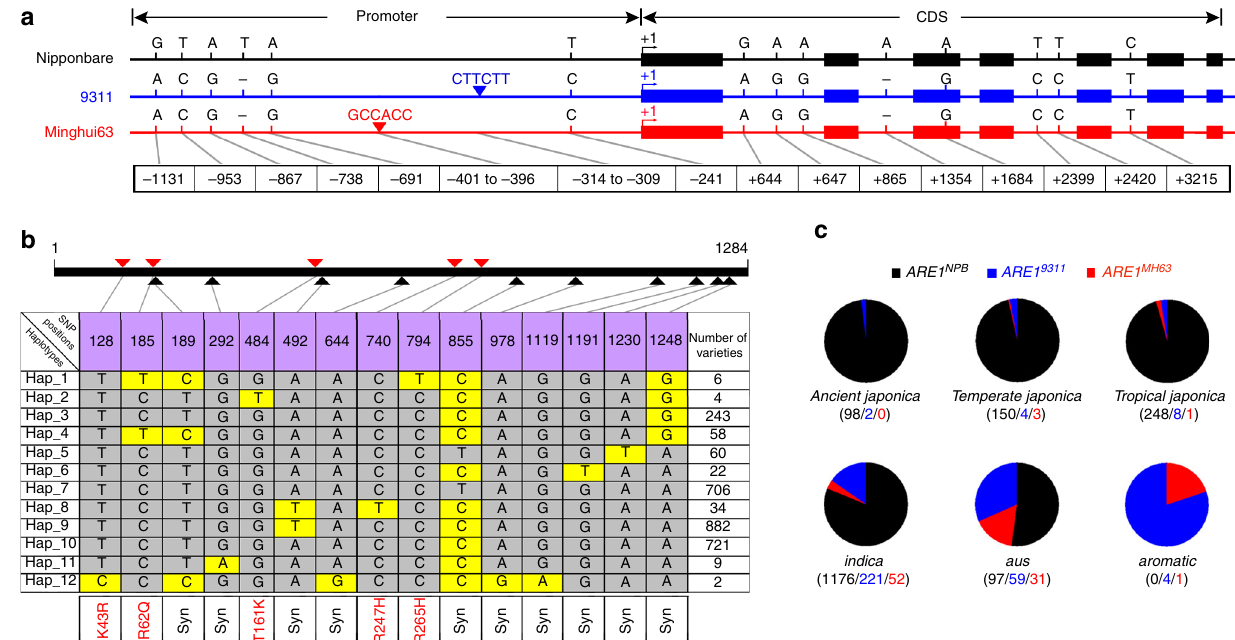
Fig. 5 Analysis of genetic variations in ARE1 . a Schematic representation of genetic variations in ARE1 in a japonica variety Nipponbare (NPB) and two indica varieties 9311 and Minghui63 (MH63). Exons are shown by fi lled boxes and other sequences are shown by lines. Numbers at the bottom indicate positions of variations (the putative transcription start is referred to as +1). CDS, coding sequences. b Major haplotypes of single nucleotide polymorphisms (SNPs) in the ARE1 coding region. Major SNP haplotypes and casual variations in the encoded amino acid residues are shown. The ARE1 coding sequences of 2747 rice varieties were compared with that of NPB (Hap_7). Twelve haplotypes were identi fi ed from these accessions and polymorphic nucleotides of each haplotype are highlighted by yellow boxes. The numbers of the identi fi ed varieties of each haplotype are shown at right. Syn, synonymous variations. c Distribution of three haplotypes of insertion-deletion polymorphisms (InDels) in the ARE1 promoter in various accessions. The numbers of the detected haplotypes (speci fi ed by different colors) are given below each